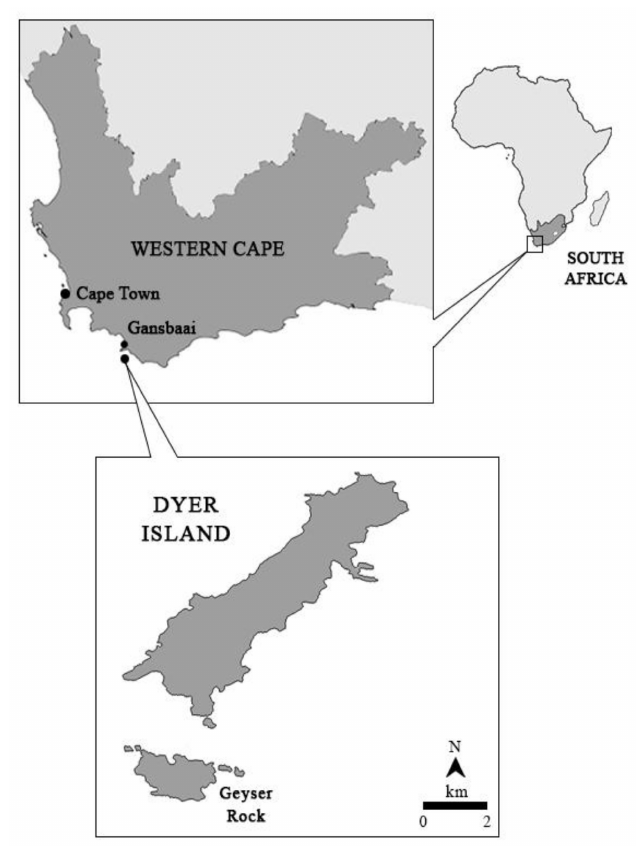
Figure 1. Study area in Dyer Island, South